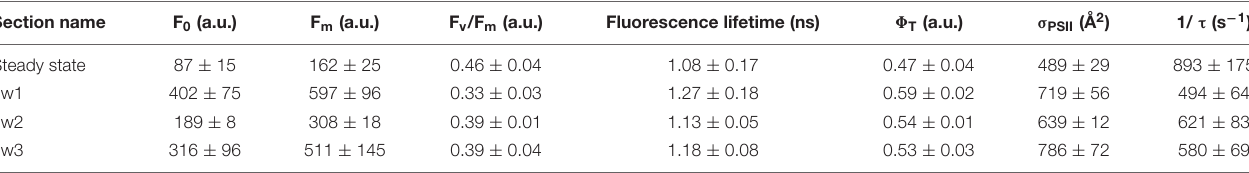
TABLE 1 | Mean values and standard deviation of photophysiology at dawn.